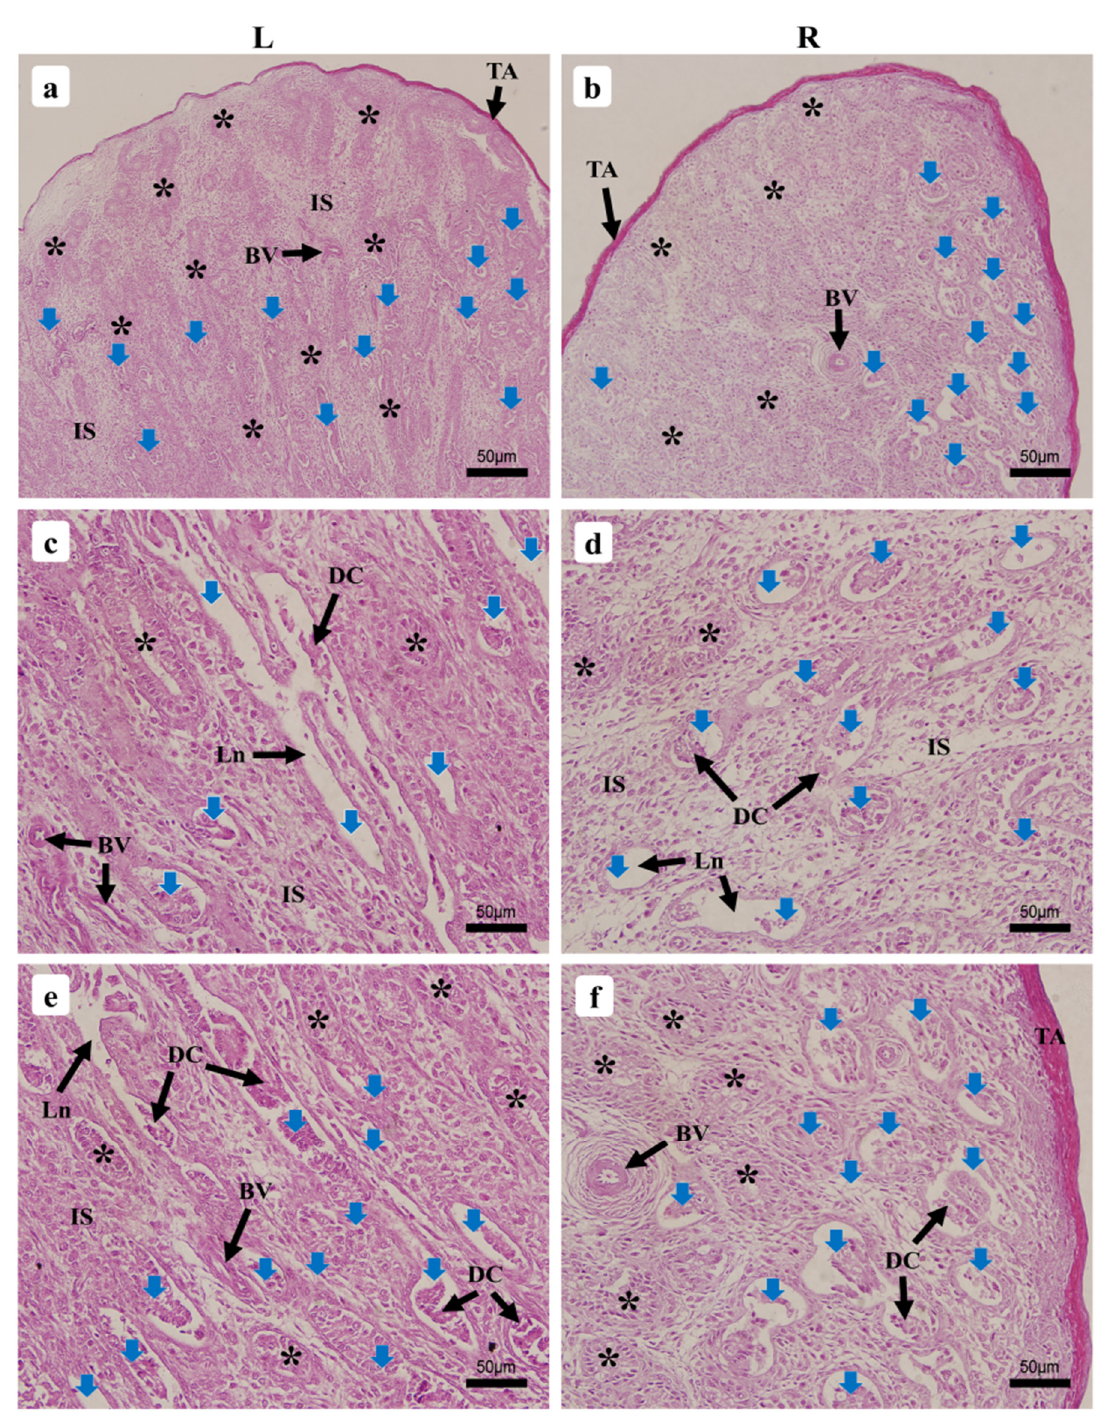
Figure 4. Histological micrographs showing seminiferous tubules’ apoptotic regression within the 1-wk-old chicken testes ( a , b ) 40× magnification, ( c – f ) 400× magnification. Left testis (L), right testis (R), normally forming seminiferous tubules (*), regressing seminiferous tubules (blue arrows), tunica albuginea (TA), interstitial space (IS), blood vessels (BV), degenerating cells (DC), lacunae (Ln).